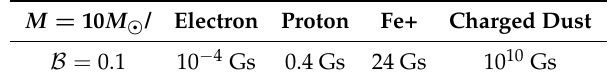
Table 1. Intensity of the magnetic field B corresponding to the magnetic parameter B = 0.1 for various types of charged particles moving in vicinity of the black hole of mass M BH ∼ 10 M (cid:12) . M = 10 M (cid:12) / Electron